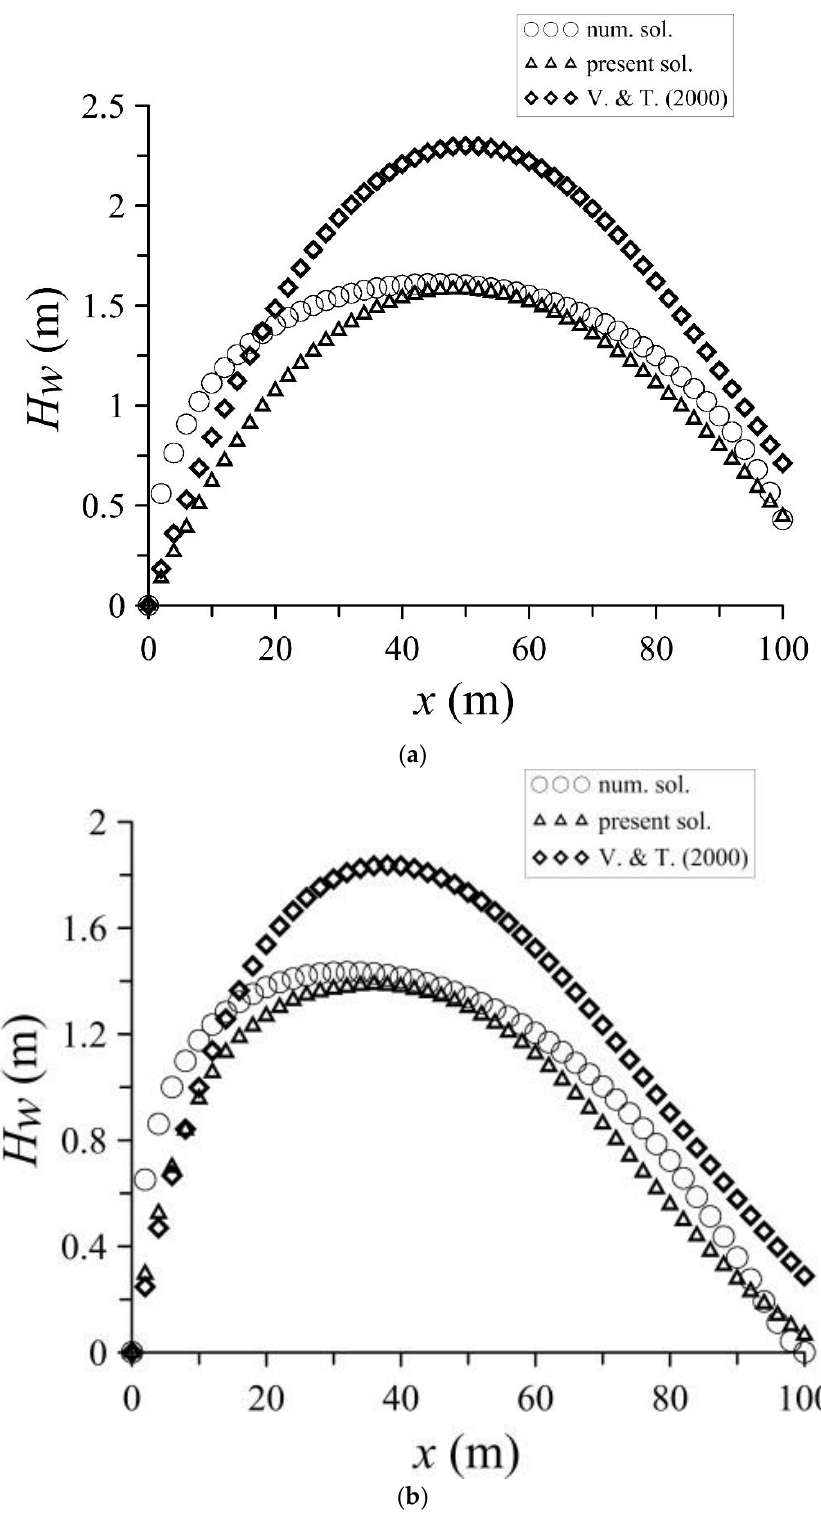
Figure 2. Spatial variation in the groundwater table under constant recharge for ( a ) 𝜃 = 2° ( b ) 𝜃 = 6° ( t = 1 day).